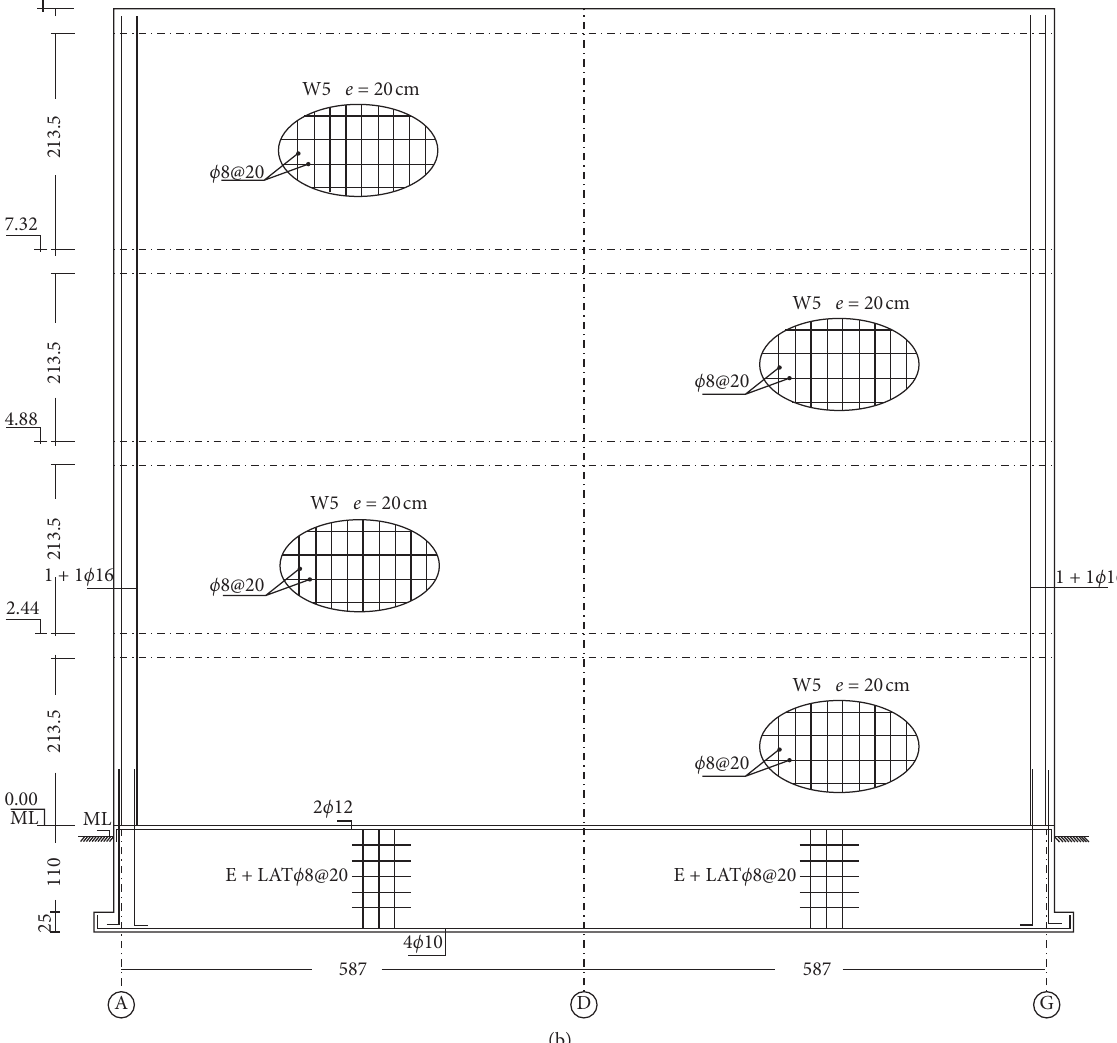
Figure 1: Sample residential housing: (a) typical floor plan of the building and (b) elevations of outer longitudinal and inner transverse shear